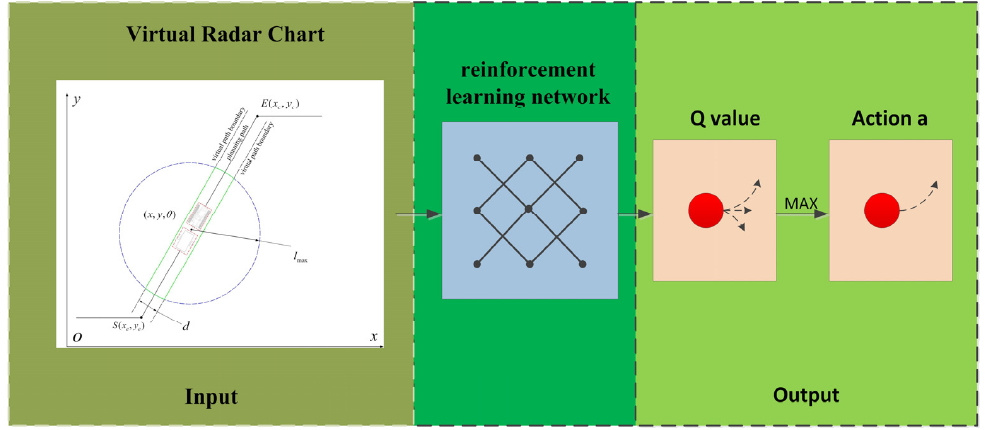
Figure 6. Overview of the network structure and the formation of its input and output layers.